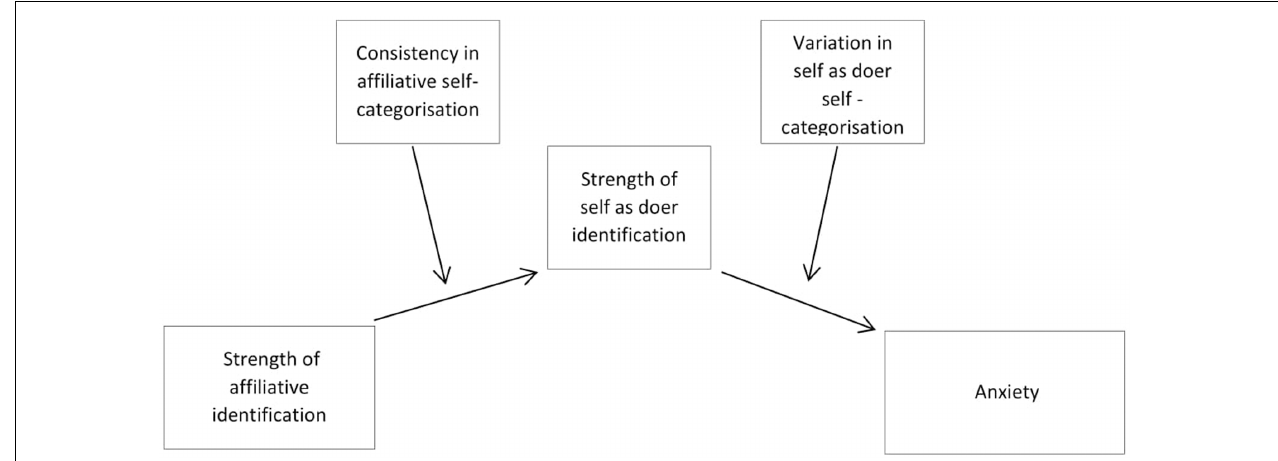
FIGURE 2 | Moderated mediation in the relationship between strength of off illative identification and anxiety via strength of self as doer identification, moderated by stability of affiliative and self as doer self-categorisations.